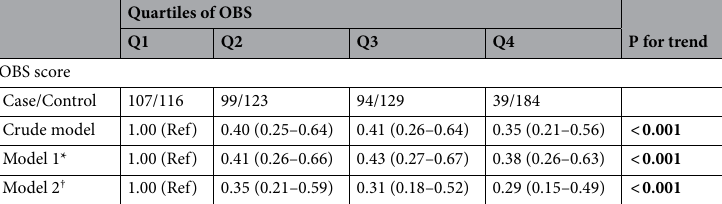
Table 3. Odds ratio (OR) and 95% confidence interval (CI) for NAFLD based on oxidative balance score (OBS). Significant values are in bold. **Binary logistic regression was used to obtain OR, 95% CI and P for trend. * Model 1: adjusted for age and sex. † Model 2: Model 1 + hip circumference, education, drug use, disease history, FBS, ALT, AST, Lipid profiles, and energy